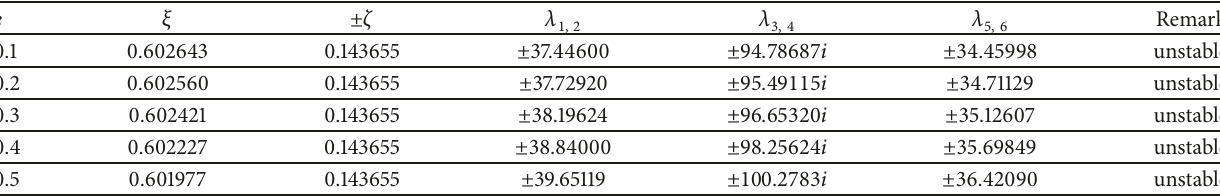
Table 3: Effects of eccentricity of PSR 1903+0327 on the locations and stability of out-of-plane points for 𝑎 = 0.95, 𝐴 = 0.02, 𝜎 1 = 0.03 and 𝜎 = 0.015. 2